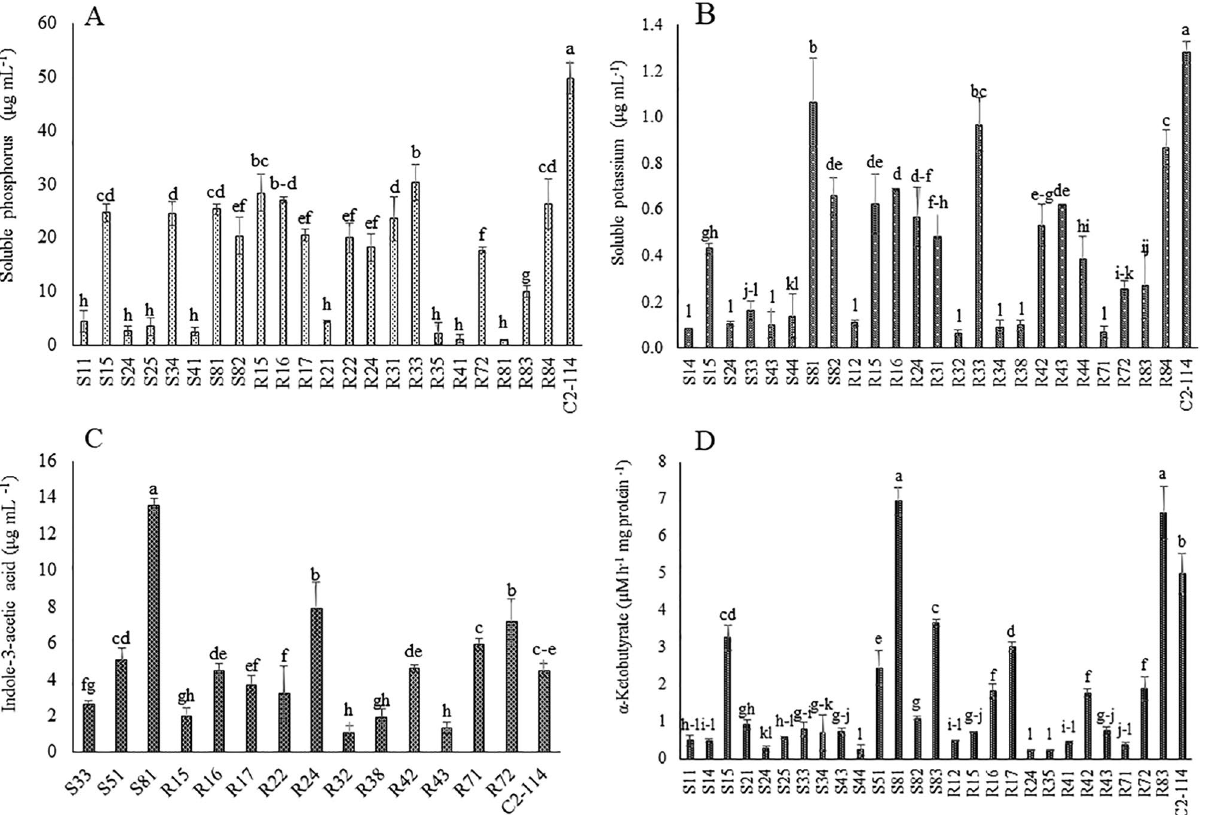
Figure 1. Quantitation of PGP activities including phosphate solubilization ( A ), potassium solubilization ( B ), indole-3-acetic acid production ( C ), and ACC-deaminase ( D ) of PGP isolates. Different letters on the bars represent significant differences ( p < 0.05) according to the LSD test.